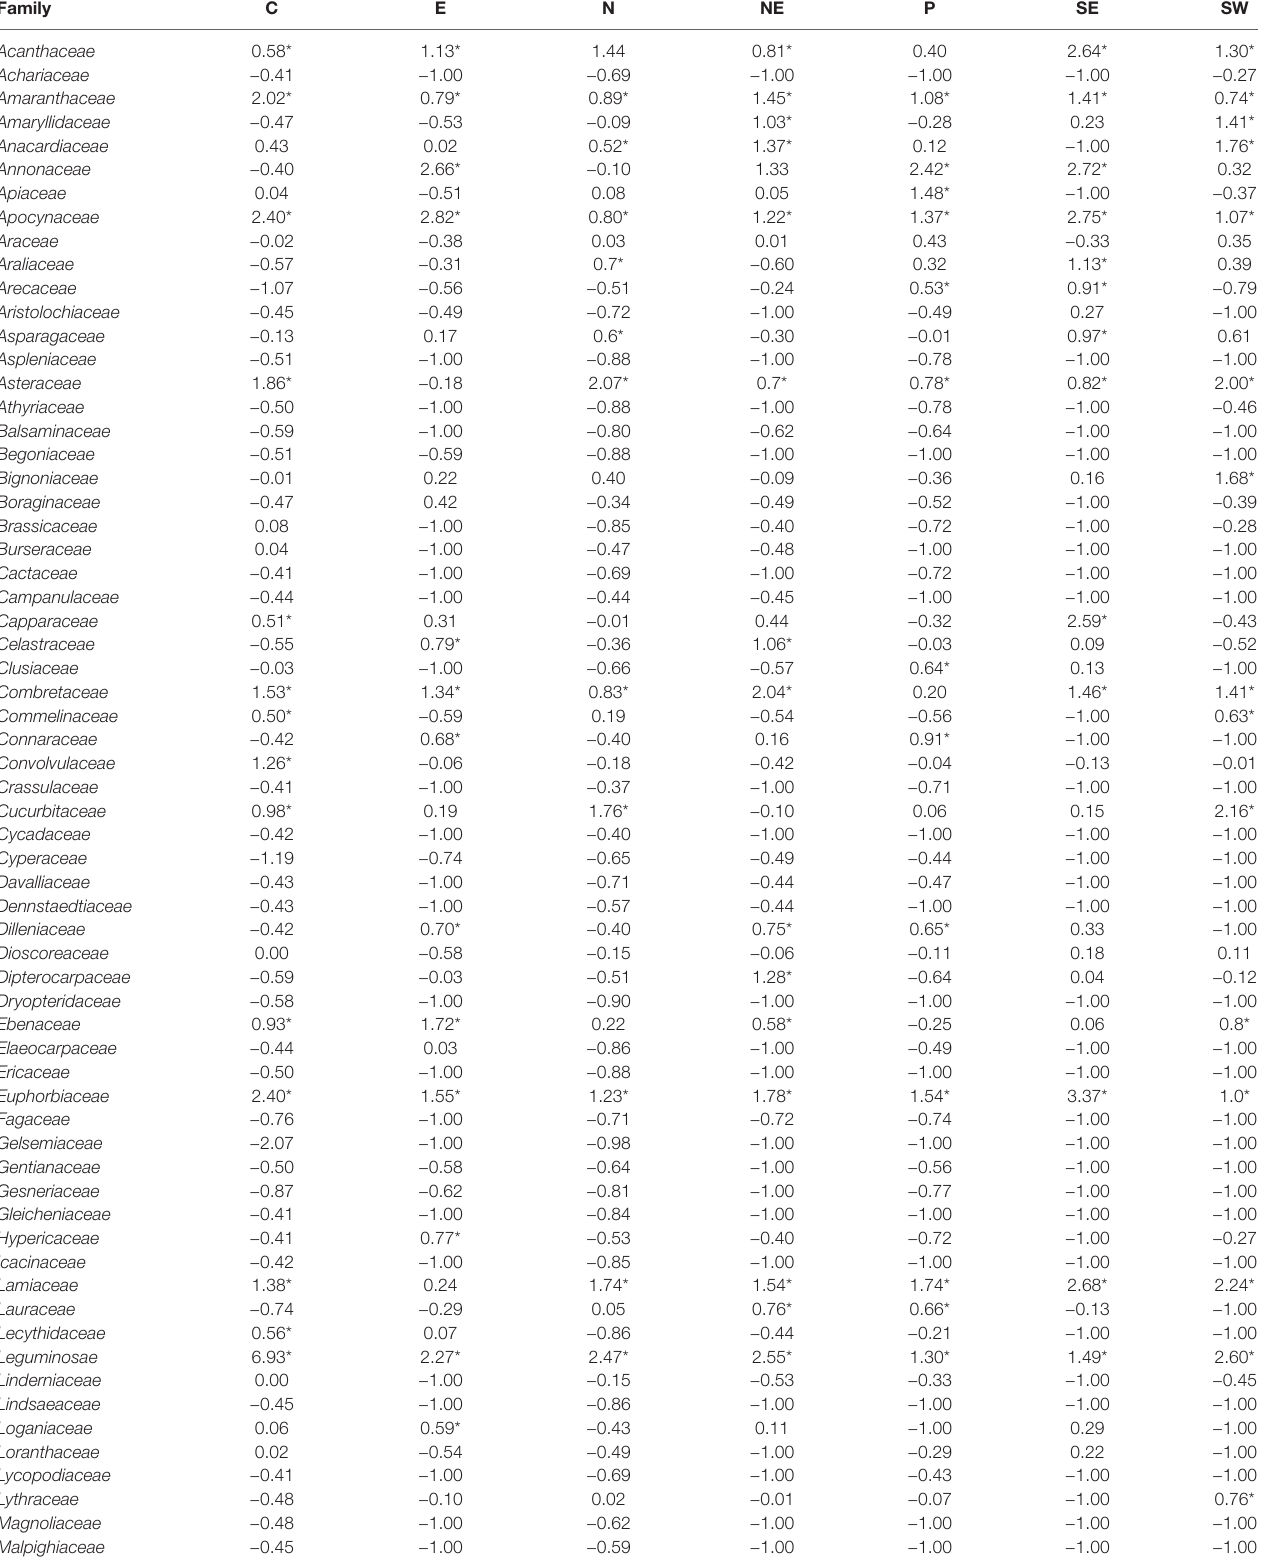
TaBle 2 | Relative regression residuals (R values) for Thai plant families in each of seven regions in Thailand as defined by Phumthum & Balslev (2018). Family C e N Ne P se sW